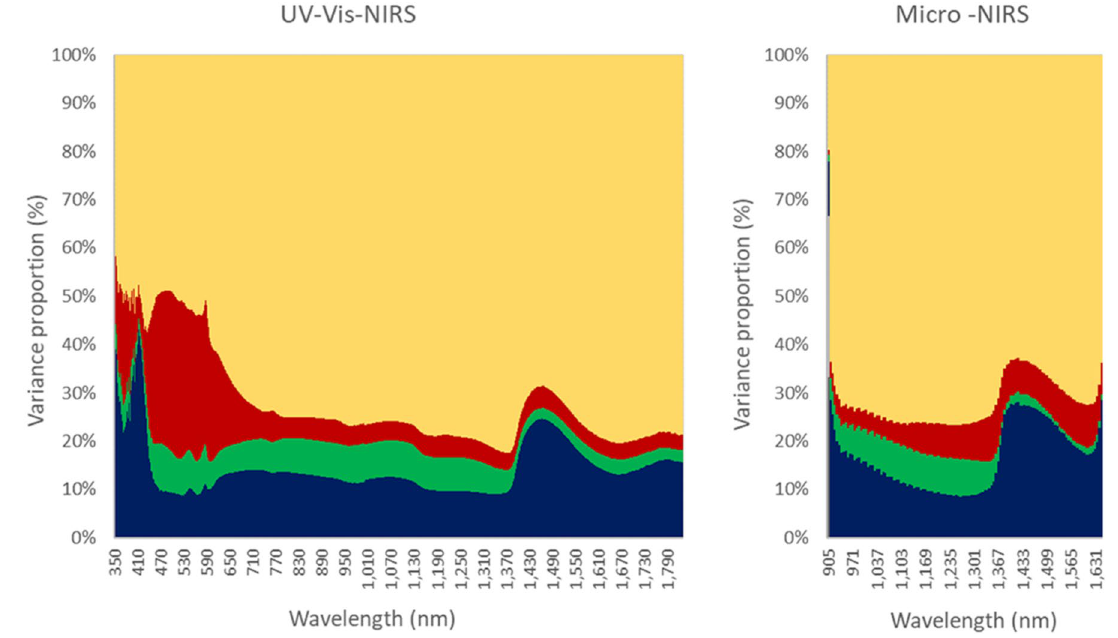
Figure 2. Proportions of the variances of the different sources of variation in absorbance. Proportion of variance due to batch (blue color), herd (green color), additive genetic (red color), and residual (yellow color) of absorbance of each individual wavelength of the spectra of Piemontese young bulls using portable UV–Vis- NIRS (left graph) and Micro-NIRS (right graph) spectrometers. Spectra taken on the 5–6th rib cross-sectional area of longissimus thoracis muscle the day after